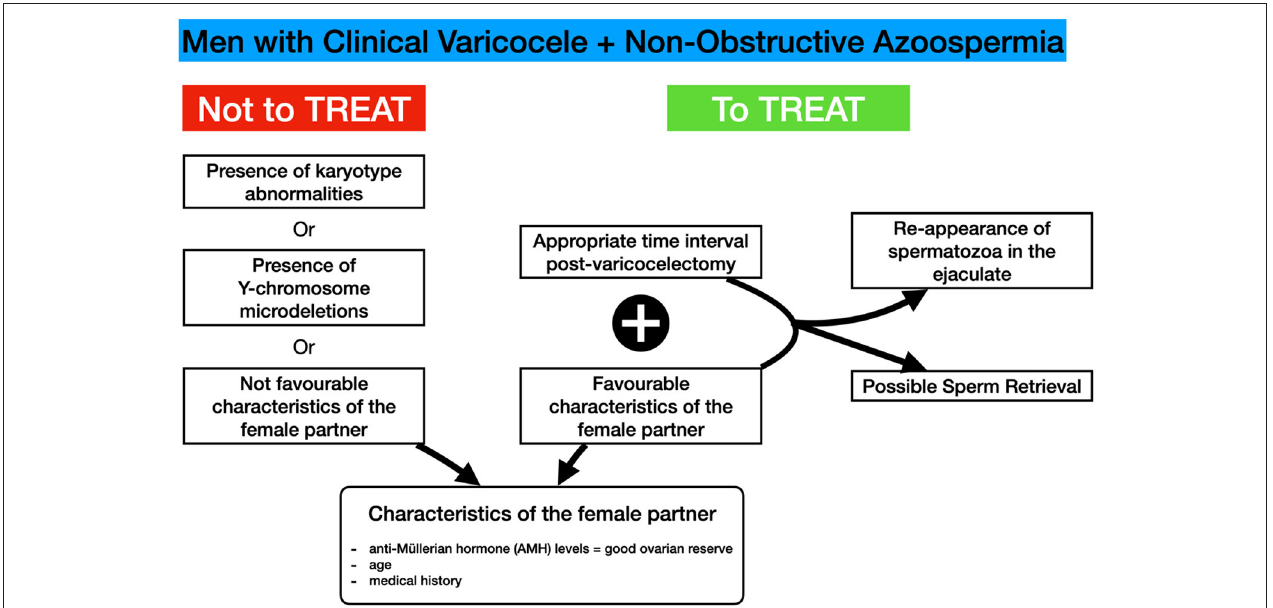
FIGURE 2 | Algorithm for the therapeutic management of NOA-men with varicoceles.